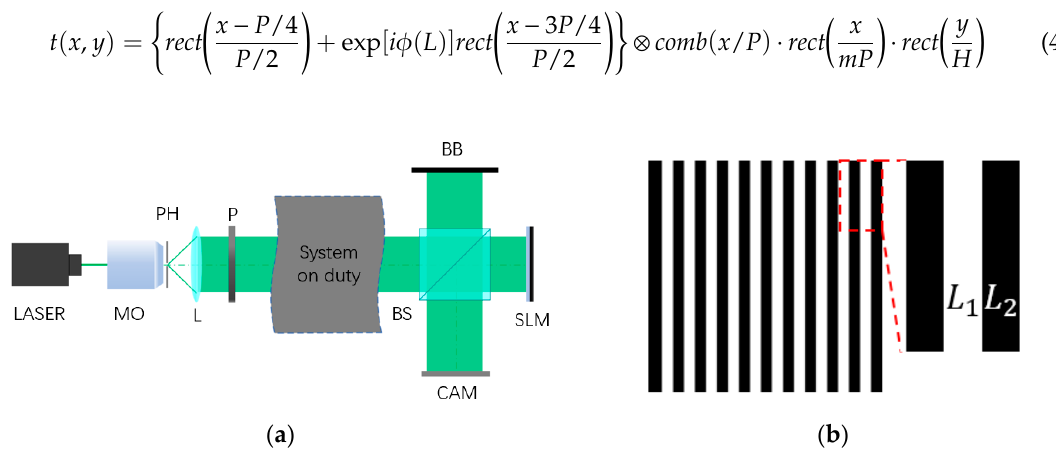
Figure 6. ( a ) Schematic of a diffraction pattern analyzed method. MO: microscope objective; PH: pinhole filter; L: collimating lens; P: polarizer; BS: beam splitter; BB: beam blocker; M: mirror; SLM: spatial light modulator; CAM: camera. ( b ) Uploaded pattern of Ronchi grating.